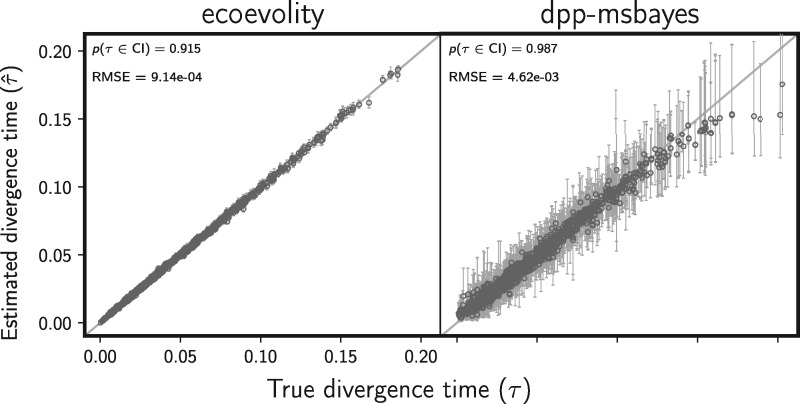
Comparing the accuracy and precision of divergence-time estimates between (left) the new full-likelihood Bayesian method, ecoevolity, and (right) the approximate-likelihood Bayesian method, dpp-msbayes. Each plotted circle and associated error bars represent the posterior mean and 95% credible interval for the time that a pair of populations diverged. Each plot consists of 1500 estimates—500 simulated data sets, each with three pairs of populations. The simulated character matrix for each population pair consisted of 200 loci, each with 200 linked sites (40,000 characters total). For each plot, the root mean square error (RMSE) and the proportion of estimates for which the 95% credible interval contained the true value—\documentclass[12pt]{minimal}
\usepackage{amsmath}
\usepackage{wasysym}
\usepackage{amsfonts}
\usepackage{amssymb}
\usepackage{amsbsy}
\usepackage{upgreek}
\usepackage{mathrsfs}
\setlength{\oddsidemargin}{-69pt}
\begin{document}
}{}$p({{t}}\in \textrm{CI})$\end{document}—is given. We generated the plot using matplotlib Version 2.0.0 (Hunter 2007)